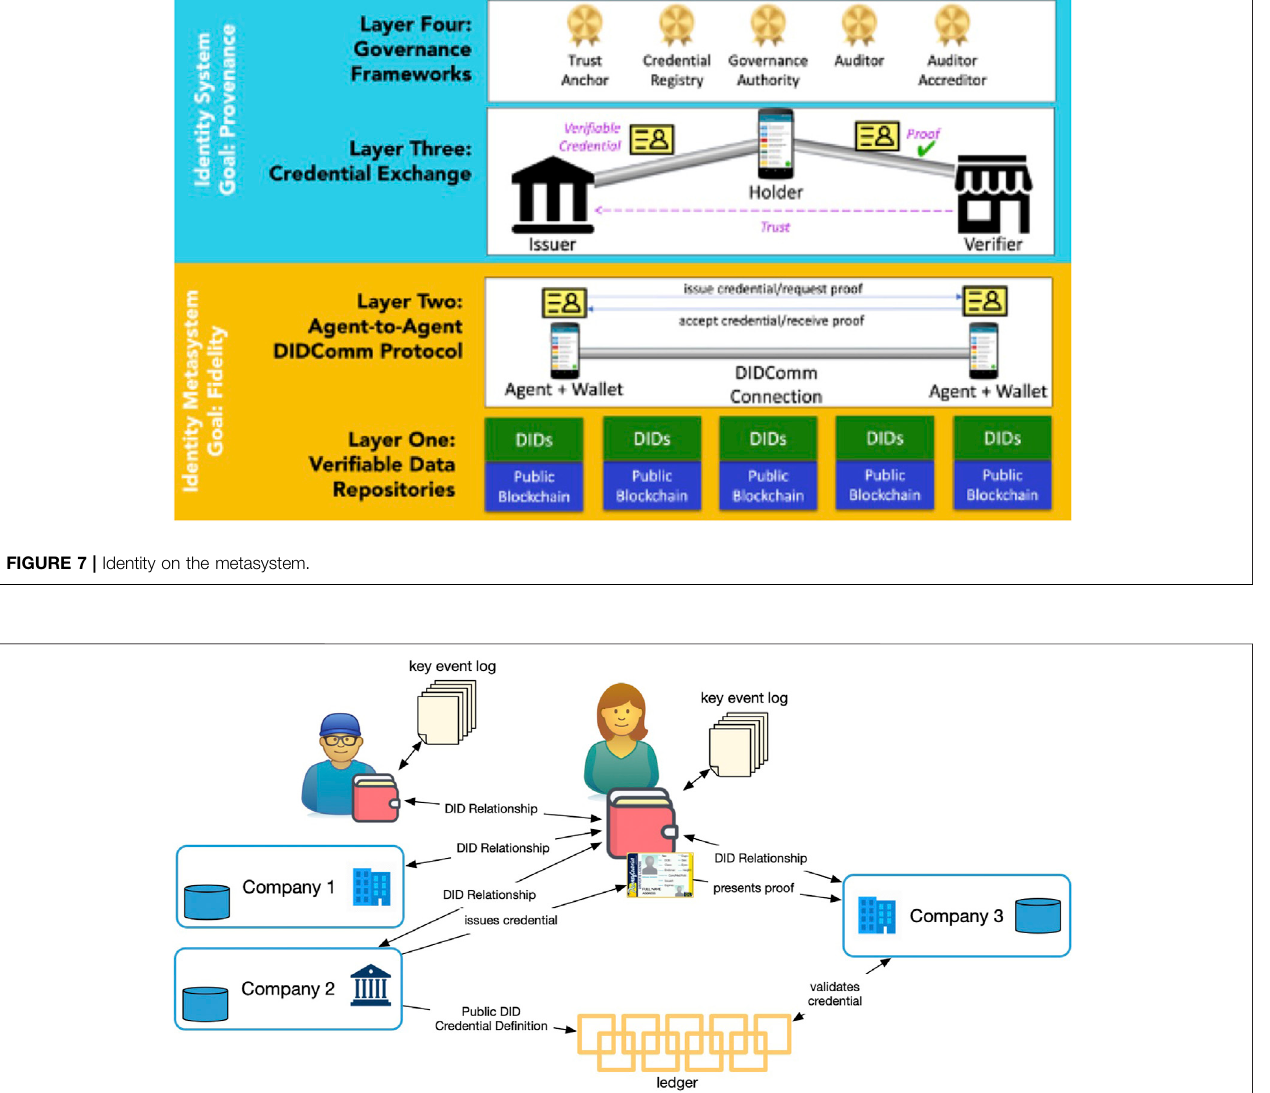
FIGURE 8 | Relationships and interactions in the Sovrin